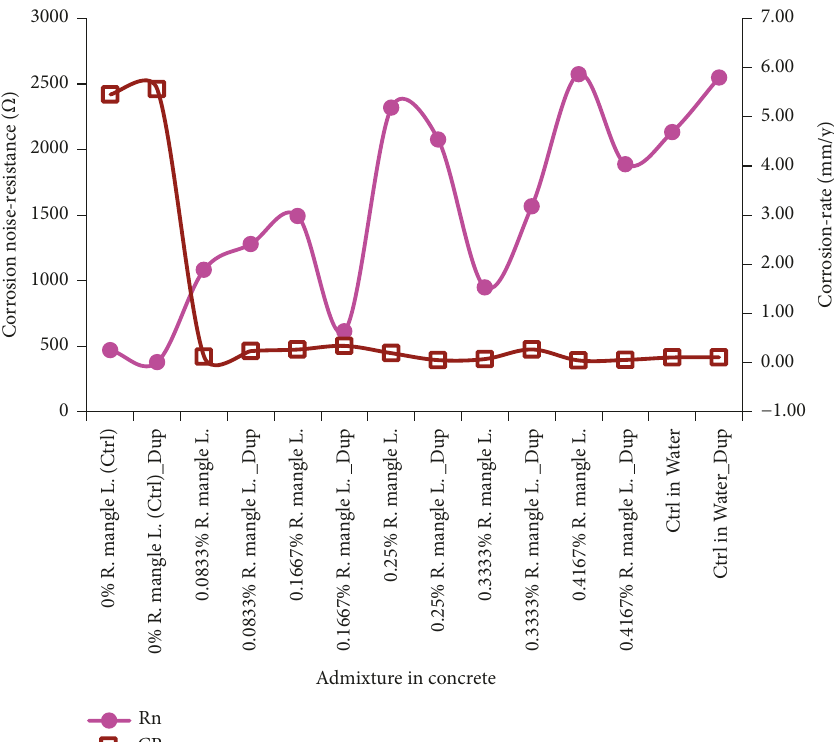
Figure 3: Electrochemical noise-resistance superimposed on corrosion-rate from specimens of steel-reinforced concrete.